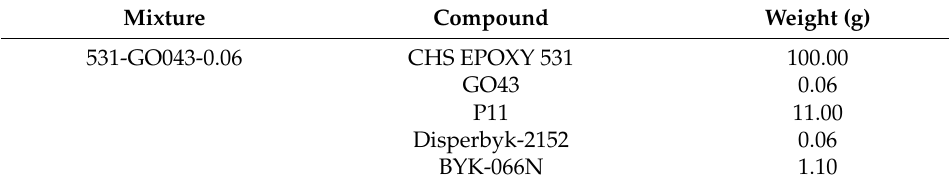
Table A15. Graphene oxide GO43 CHS Epoxy 531, 0.06